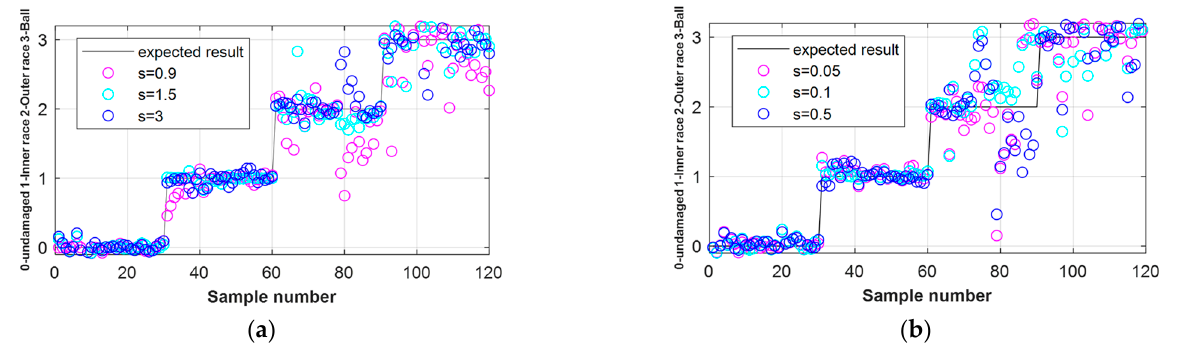
Figure 11. Waveforms of output values from the fault classifier (type II) for different spread values of RBF network based on input vectors from ENV ( a ) or FFT ( b ) analyses.